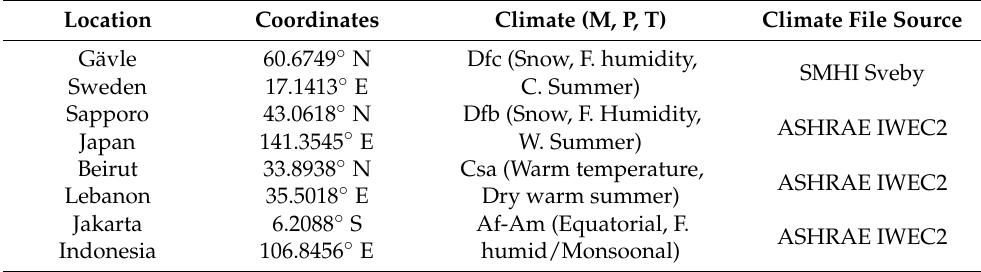
Figure 5. Solar angles in various locations: ( A ) Gävle, ( B ) Sapporo, ( C ) Beirut, and ( D ) Jakarta [22]. Table 5. Evaluated locations (cities and countries), climate type, and climate file source.